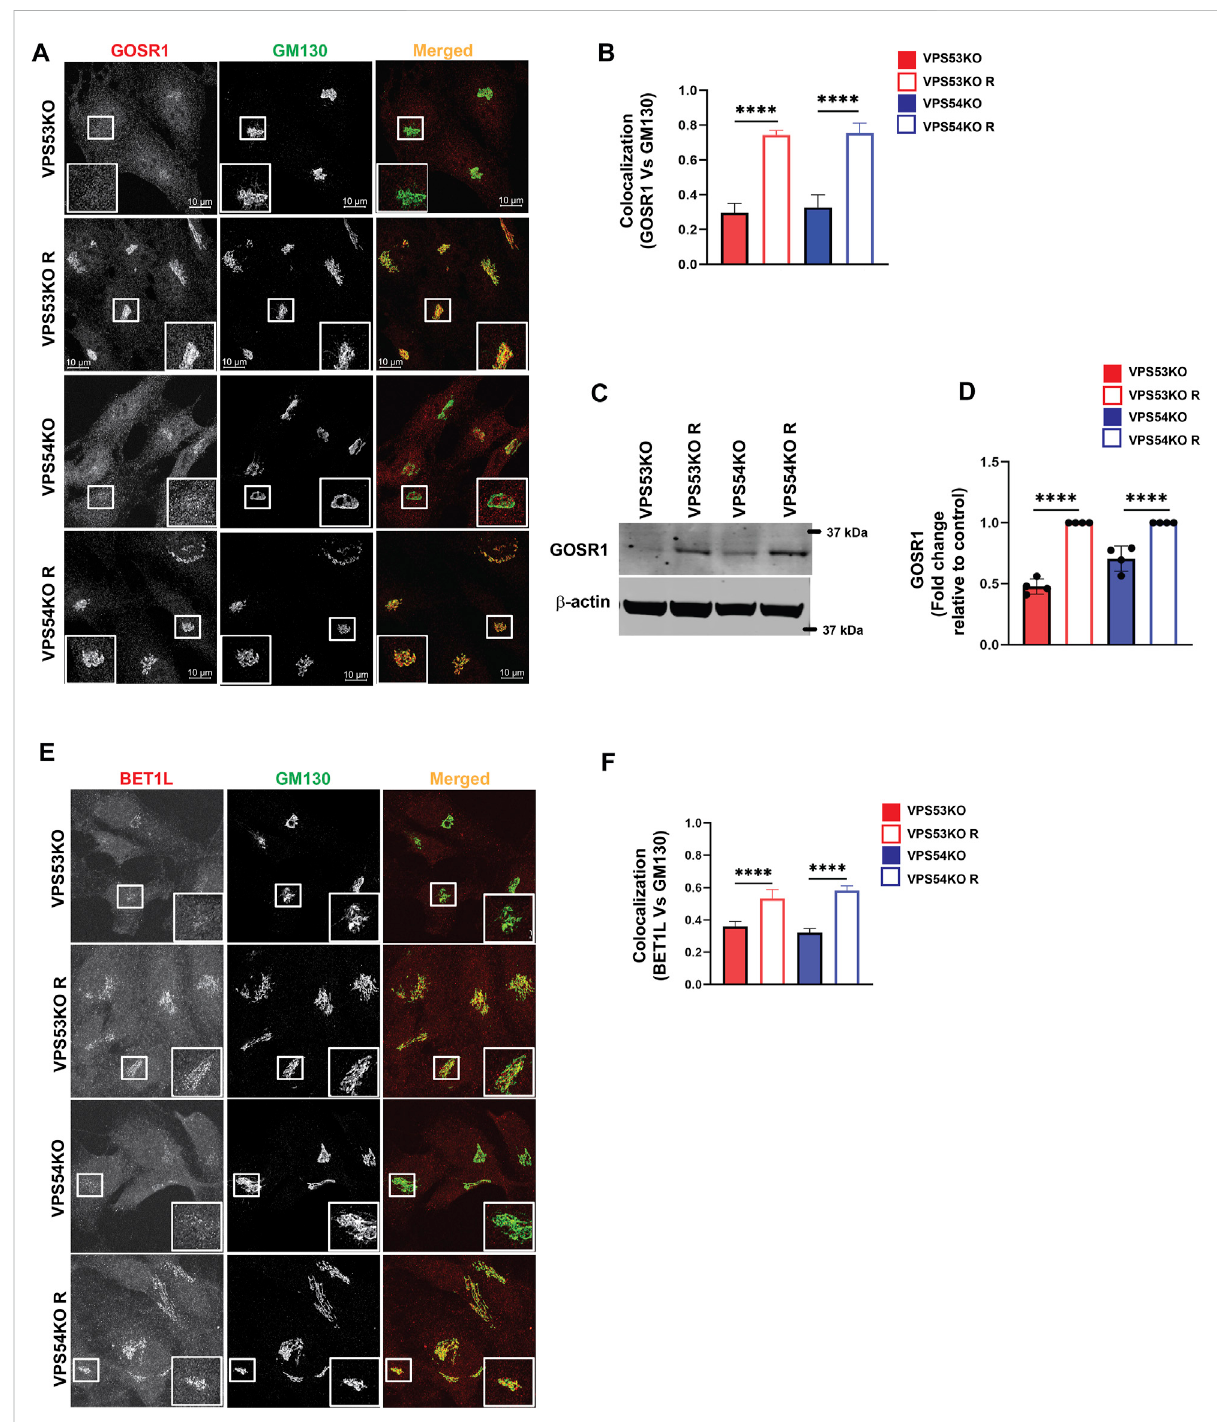
FIGURE 4 GARP-KOalterslocalizationandexpressionofintra-Golgiv-SNAREsGOSR1andBET1L. (A) AiryscanmicroscopyofGARP-KOsandcontrolcells co-stained for GOSR1 and GM130. The large white square box inside the image is the zoomed view of the small square box (2X inset). (B) The graph shows the quanti fi cation of GOSR1 and GM130 colocalization. Values in the bar graph represent the mean ± SD from the colocalization between GOSR1andGM130from40differentcells. (C) WBanalysisofGOSR1proteinlevelinVPS53KO,VPS54KO,andtheircontrols. β -actinwasusedas internalloadingcontrol. (D) Quanti fi cationoftheblotsfromfourindependentexperiments. (E) AiryscanimagingofVPS53KO,VPS53KOR,VPS54KO, VPS54KORcellsco-stainedforBET1LandGM130.Thelargewhitesquareboxinsidetheimageisthezoomedviewofthesmallsquarebox(2Xinset). (F) Colocalization analysis between BET1L and GM130 using Pearson ’ s correlation coef fi cient. n = 40 cells were imaged per group for the quanti fi cation. Statistical signi fi cance was calculated using one-way ANOVA. **** p ≤